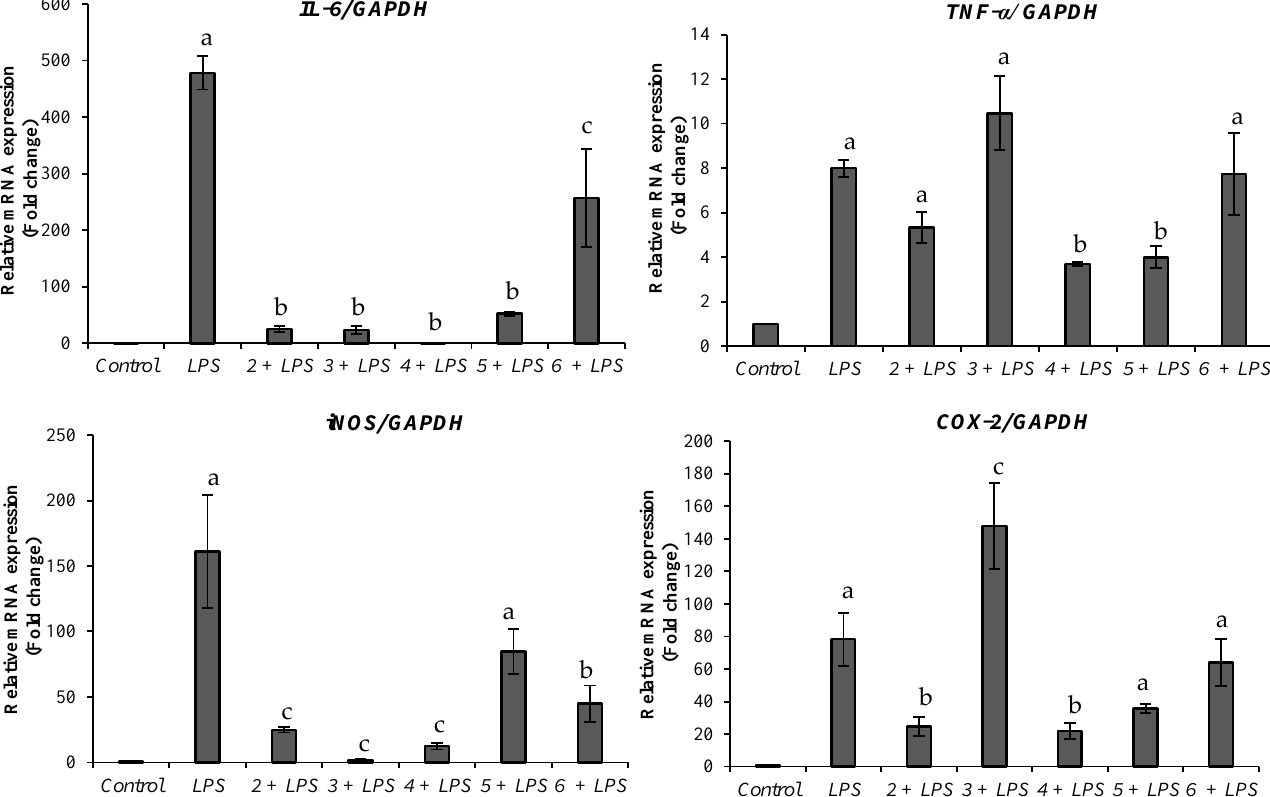
Figure 3. Effect of purified compounds on mRNA expression of IL-6 , TNF- α , iNOS , and COX-2 in LPS-induced murine macrophage RAW 264.7 cells. The cells were pretreated with 50 µ M karaviloside VI ( 2 ), karaviloside VIII ( 3 ), momordicoside L ( 4 ), momordicoside A ( 5 ), and charantoside XV ( 6 ) followed by LPS (1 µ g/mL) stimulation. Data are expressed as mean ± SD ( n = 9) and analyzed by one-way ANOVA with a Tukey post hoc test. Different letters within the same plot indicate the significant differences at p < 0.05.